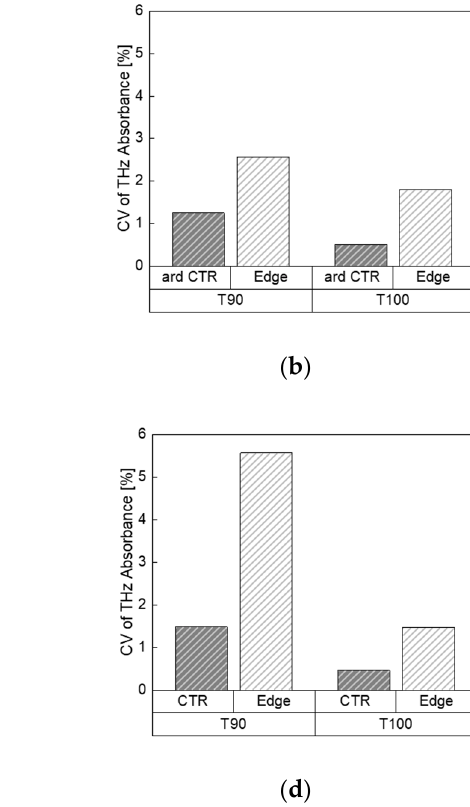
Figure 5. Thick rubber sample for detailed analysis in this study. ( a ) Coordinate axes and sliced areas (#1~#6) in the sample, ( b ) the “around the center” (36 points) and its surroundings (“edge,” 114 points), and ( c ) the center (10 points) and its surroundings (“edge,” 140 points).